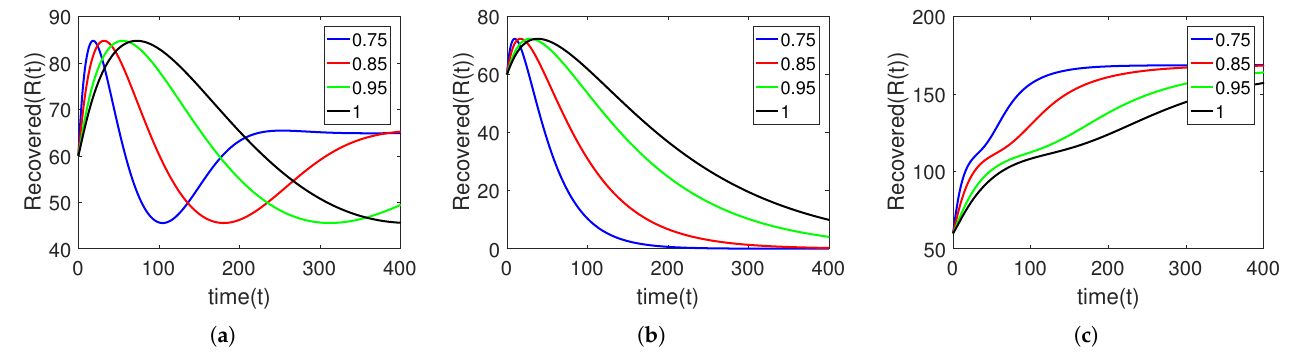
Figure 16. Graphical view ( a – c ) of Recovered class on different arbitrary orders γ = 0.75, 0.85, 0.95, 1 for initial data and time duration for TB model by taking the value of β = 0.75, 0.075, 1.75.